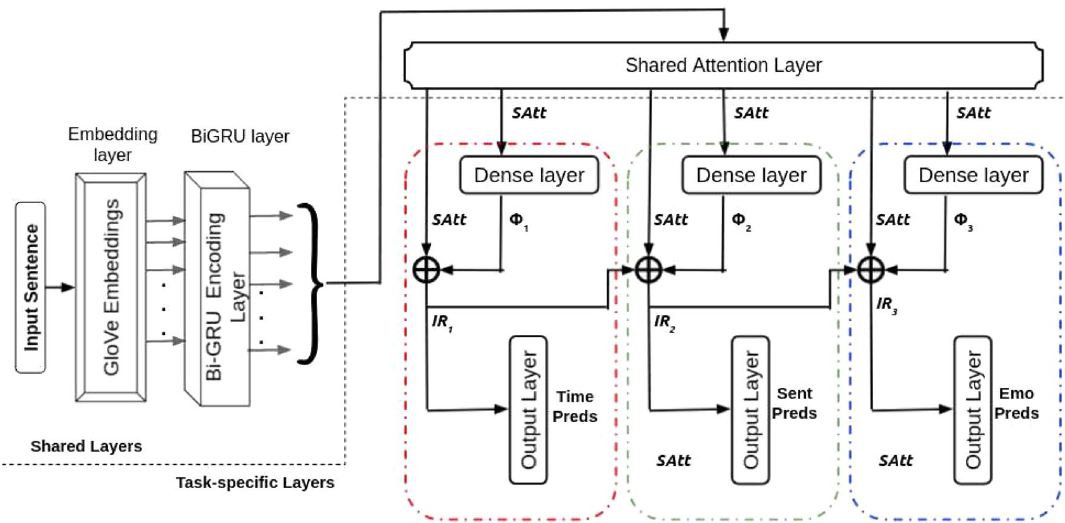
Figure 4. Architecture of shared attentive network with multi-layer cascades. Colour coded red, green and blue dotted lines depicts the three sub-networks participating in the layer cascading.